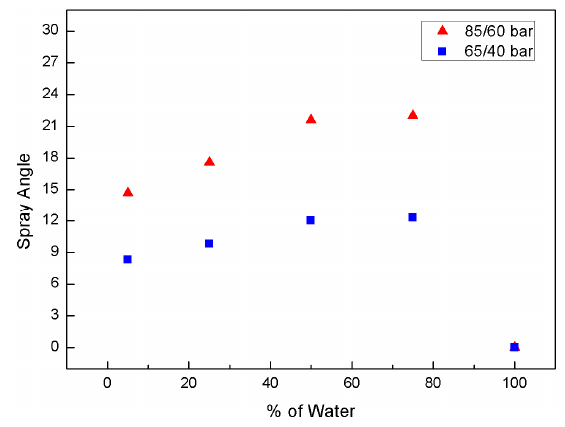
Figure 6. Effect of water-blending ratio in water-CO 2 mixture on spray angle at 85/60 bar.